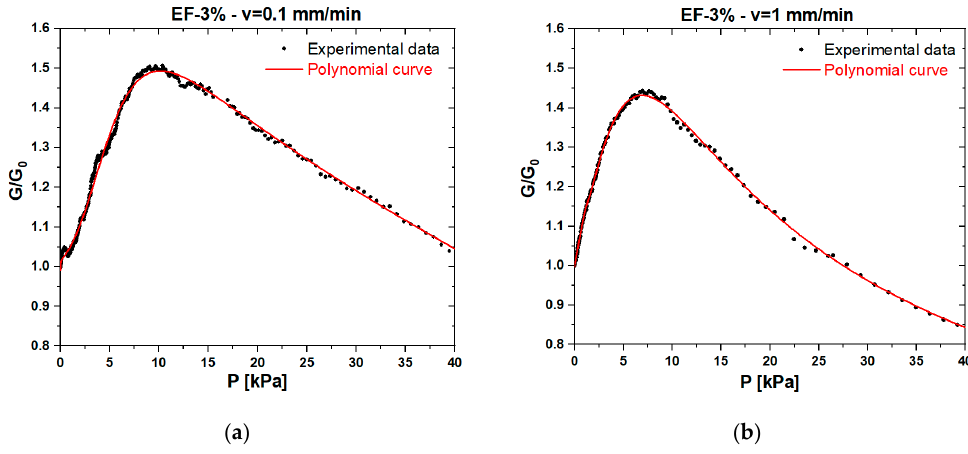
Figure 10. Normalized conductance vs. pressure and corresponding polynomial fitting curves obtained at a speed of 0.1 ( a ) and 1 ( b ) mm/min for the EF-3% sample.